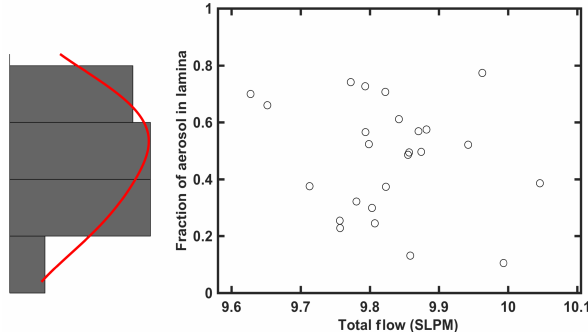
Figure 4. Measured f lam as a function of total flow in SPIN at 20 ◦ C, varied around a nominal value of 9.8slpm. In the ideal case, where all particles are constrained with the dash-dotted lines in Fig. 2, data points should form a horizontal line at 1.0. This fig- ure illustrates that the ideal condition is not realized and that even within a few % of the nominal total flow of 9.8Lmin − 1 , the fraction of particles in the lamina is not predictable. The histogram on the left is a distribution of f lam with the corresponding kernel density estimate shown in